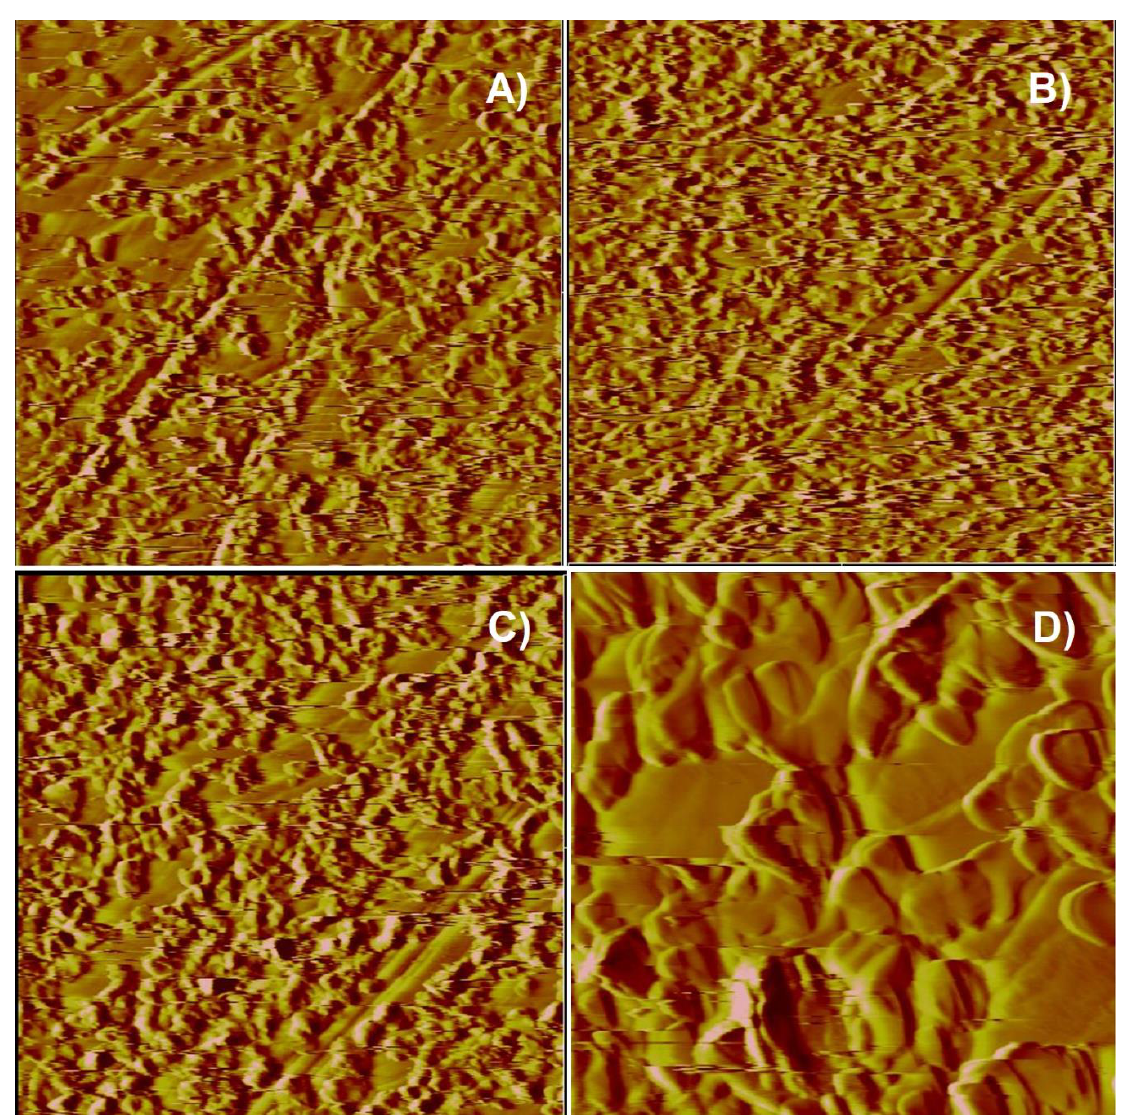
Figure 12. AFM height images (5 µm × 5 µm) with a data scale of 20 nm of a bornite surface soaked in the 5 × 10 − 4 M KEX solution at pH 10 ( A ) for 5 min, ( B ) for 10 min, ( C ) for 20 min and ( D ) for 20 min (1 µm × 1 µm).